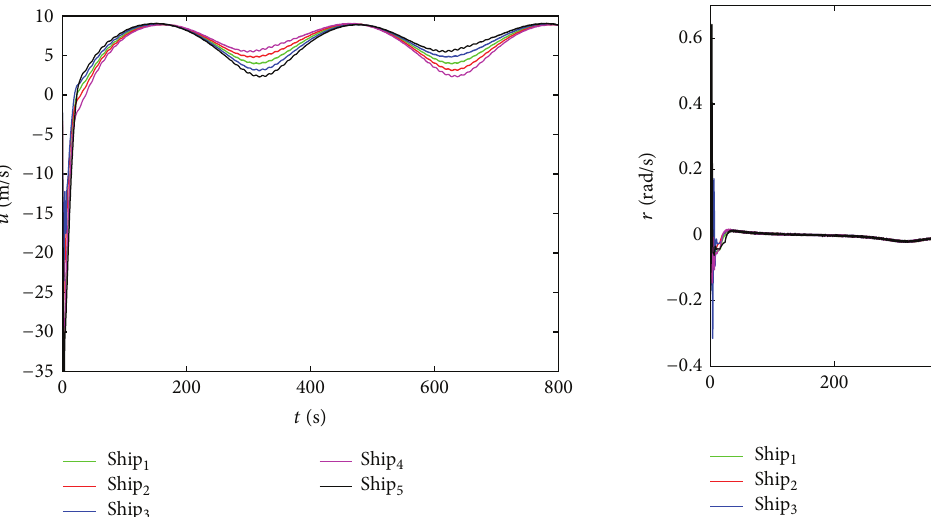
Figure 4: The surge velocity curve of each vessel.